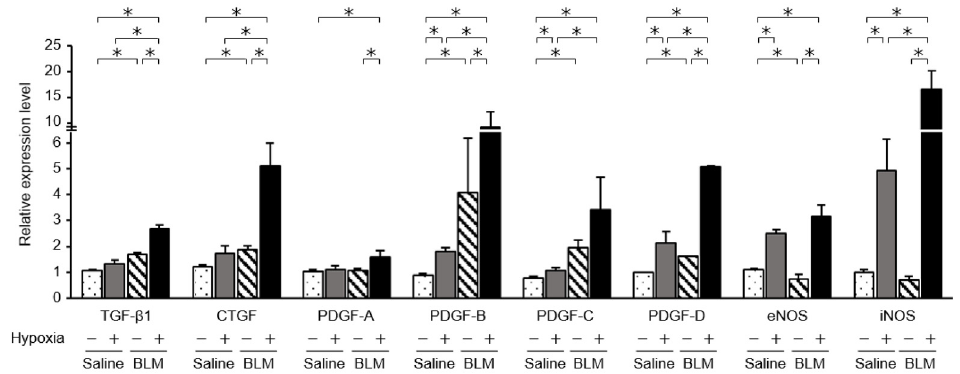
Figure 2. Expression of mediators, determined by quantitative real-time PCR. mRNA levels of various mediators were compared between endothelial cells from saline- and bleomycin-treated mouse lungs. Quantitative real-time PCR was performed using three independently prepared cDNA samples from endothelial cells harvested from saline- or bleomycin-treated lungs on day 7. Results were normalized to expression levels in endothelial cells from untreated lungs at day 0. Data are means ± standard error of the mean for three mice. * p < 0.05.